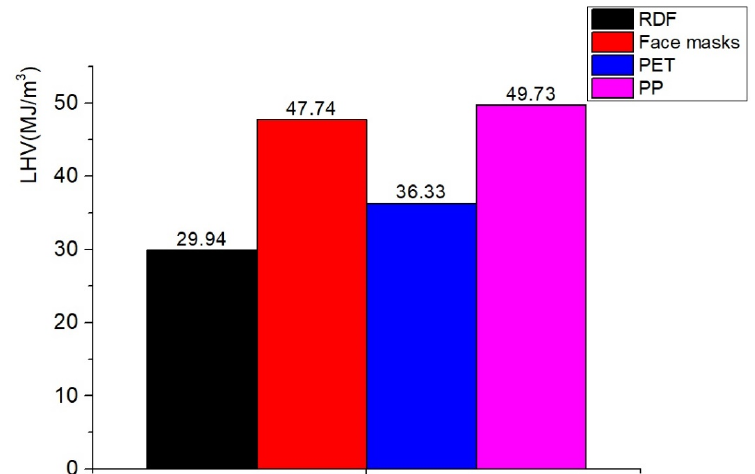
Figure 10. Calorific value of gas from pyrolysis of selected waste.